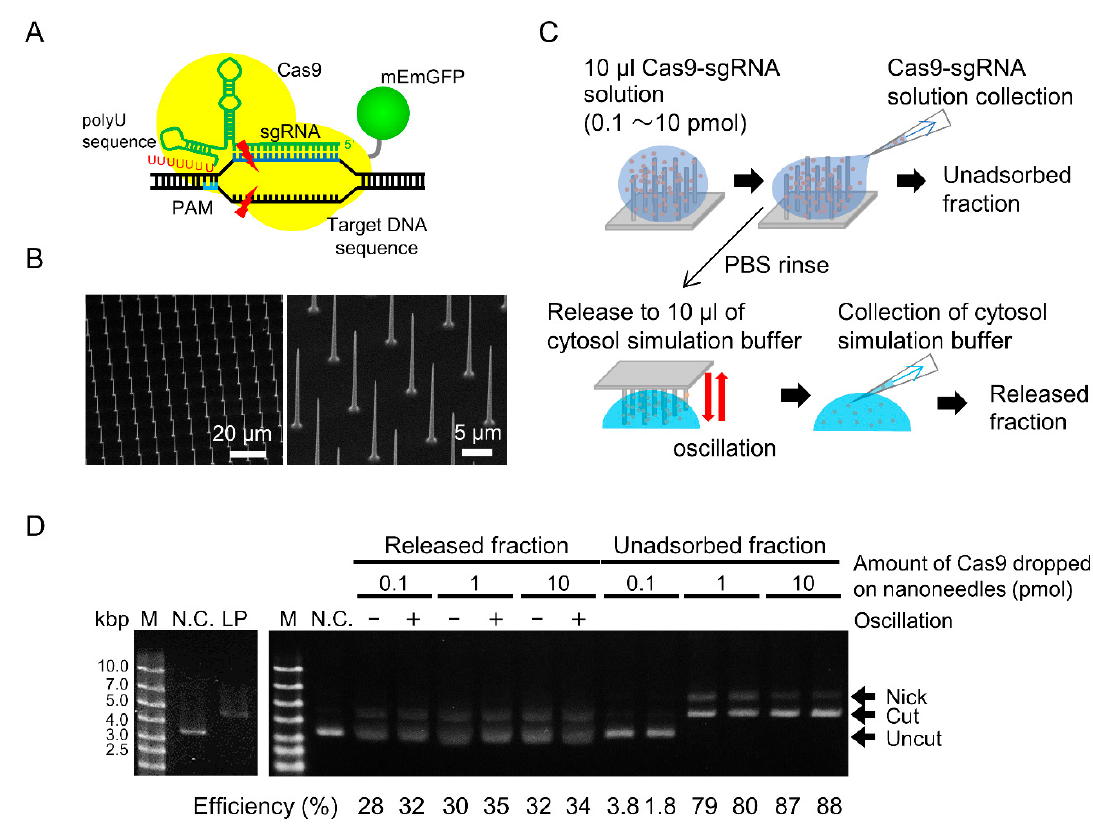
Figure 1. Estimation of cleavage activity of RNP released from nanoneedle array (NNA). ( A ) A schematic of Cas9 and poly-U containing single guide RNA (sgRNA) ribonucleoprotein (RNP) cleaving double stranded DNA. ( B ) Scanning electron microscope images of fabricated NNAs. ( C ) Schematic of RNP adsorption and release. The RNP solution was poured on the hydrophobized NNA and collected as the unadsorbed fraction. The RNP-adsorbed nanoneedle array was immersed in cytosolic simulation buffer. The buffer was then collected as the released fraction. ( D ) Electrophoresis of cleaved plasmid DNAs in unadsorbed and released fractions. Super-coiled plasmid DNA coding EGFP (negative control, N.C.) and linearized plasmid (LP) by restriction enzyme were used.